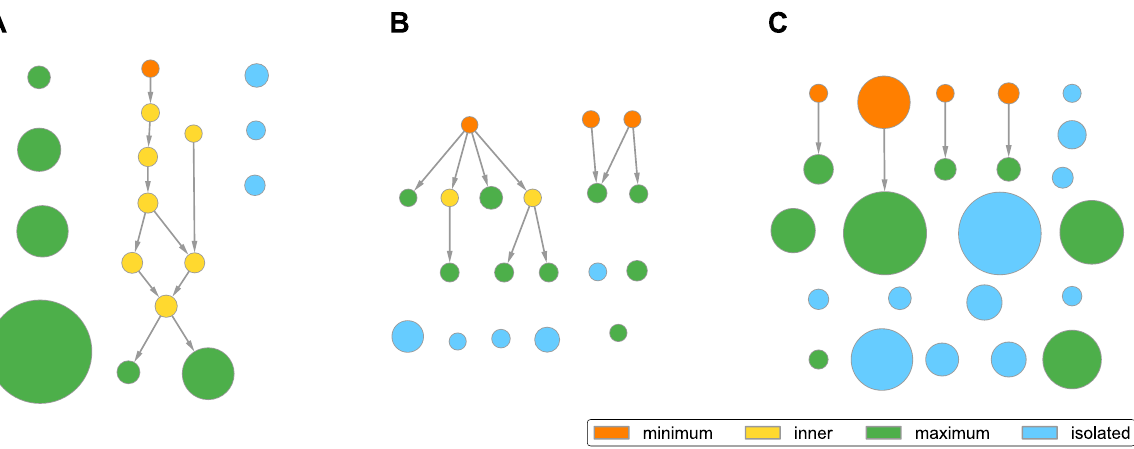
Figure 7. Examples of subgraphs of complex hierarchies induced by proteins. Each panel shows a subgraph of the entire hierarchy induced by the set of nodes containing a single selected protein. Each node’s size indicates the participation ratio for the corresponding weight function, while its color indicates the topological type (see legend). An arrow linking two nodes indicates an approximately-part-of relationship. For clarity, only the ‘direct’ links are shown, while the links that could be replaced by a sequence of two or more direct links were removed. A Yeast ELP3 protein; B Human RPTOR protein; C Yeast GSY2 protein.